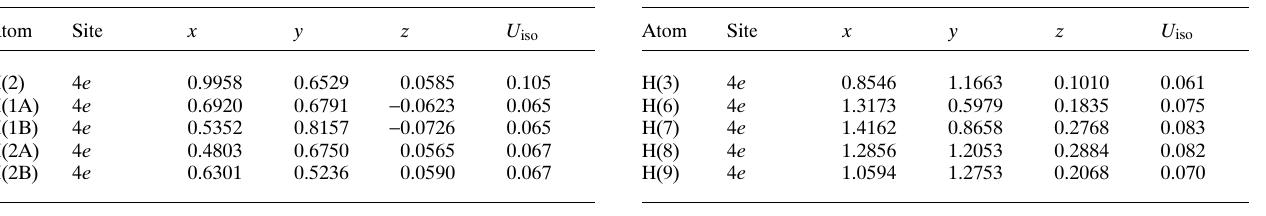
Table 2. Atomic coordinates and displacement parameters (in Å 2 )